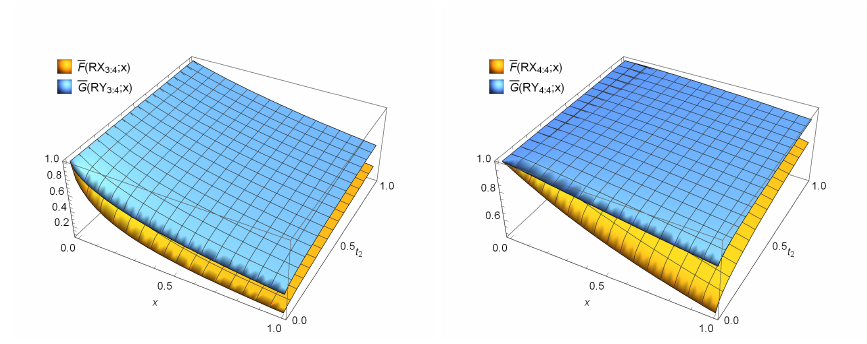
Figure 9. The reliability functions of RX 3:4 and RY 3:4